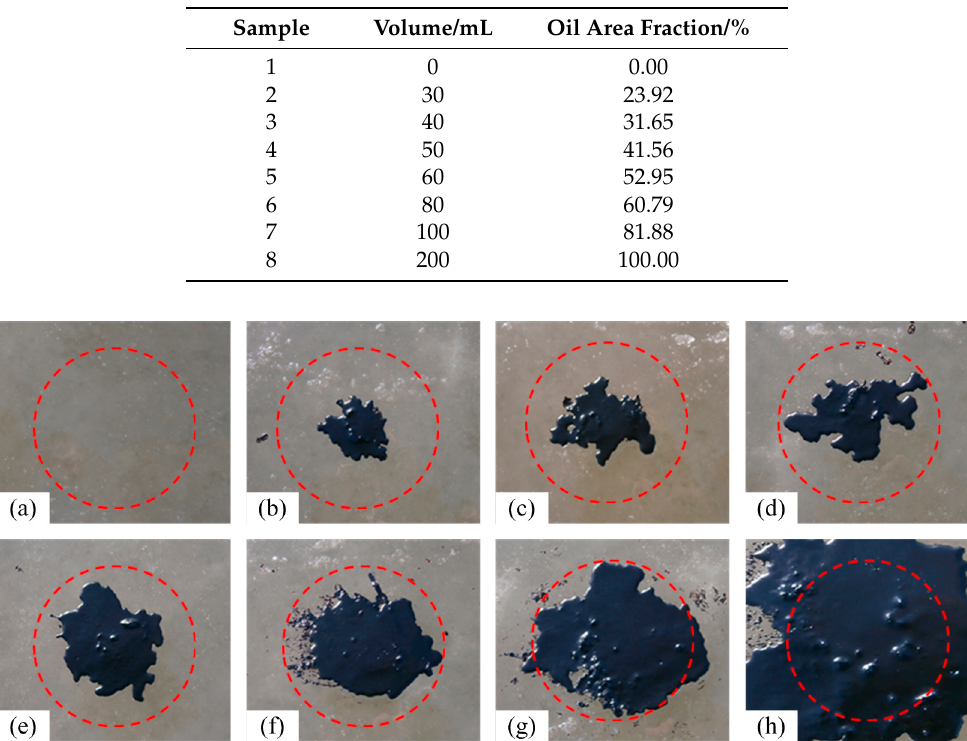
Table 1. Proportion of oil-polluted area in each sample area.